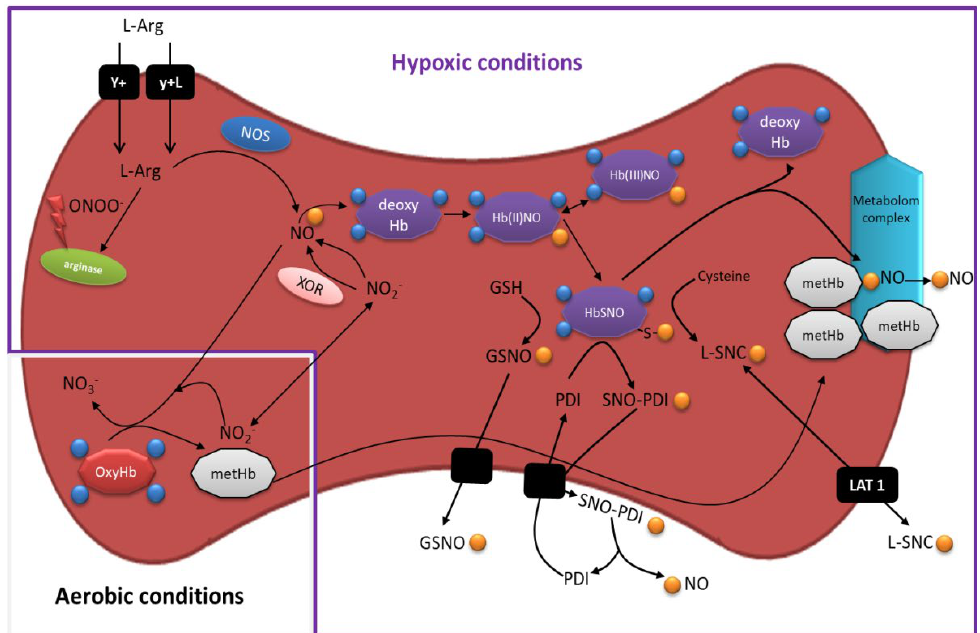
Figure 1. Nitric oxide metabolism in erythrocytes under aerobic and hypoxic conditions. In aerobic conditions, OxyHb reacts with NO, forming metHb and NO 3 − -metabolic end products. However, in a hypoxic environment, RBCs become a NO producer. L-arginine is transported through the RBCs membrane by y+ and yL. Subsequently, it is incorporated into NOS or the arginase pathway, depending on the redox RBCs status. NO reacts with deoxyHb and further undergoes S-nitrosylation, forming HbSNO. NO is finally transmitted to GSH, PDI, or cysteine and, as a steady intermediate, leaves the RBCs. Alternatively, NO 2 − is reduced by XOR or deoxyHb and turned into another NO source. Abbreviations: GSH: glutathione; GS-NO: S-nitrosoglutathione; HbSNO: S-nitroso hemoglobin; LAT 1: L-neutral amino acid transporter 1; L-SNC: S-nitroso-L-cysteine; SNO-PDI: S- nitrosylated protein disulphide isomerase; PDI: protein disulphide isomerase; XOR: xanthine oxidoreductase .